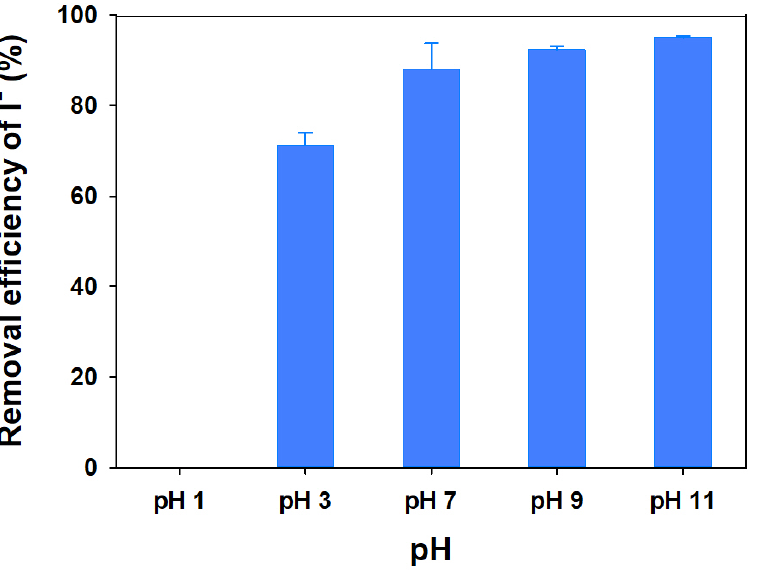
Figure 13. Removal efficiency of I − as a function of pH on the mag@silica-Ag composite. Adsorbent 0.01 g, I − solution 10 mL, 24 h, 25 °C. 0.01 g, I − solution 10 mL, 24 h, 25 ◦